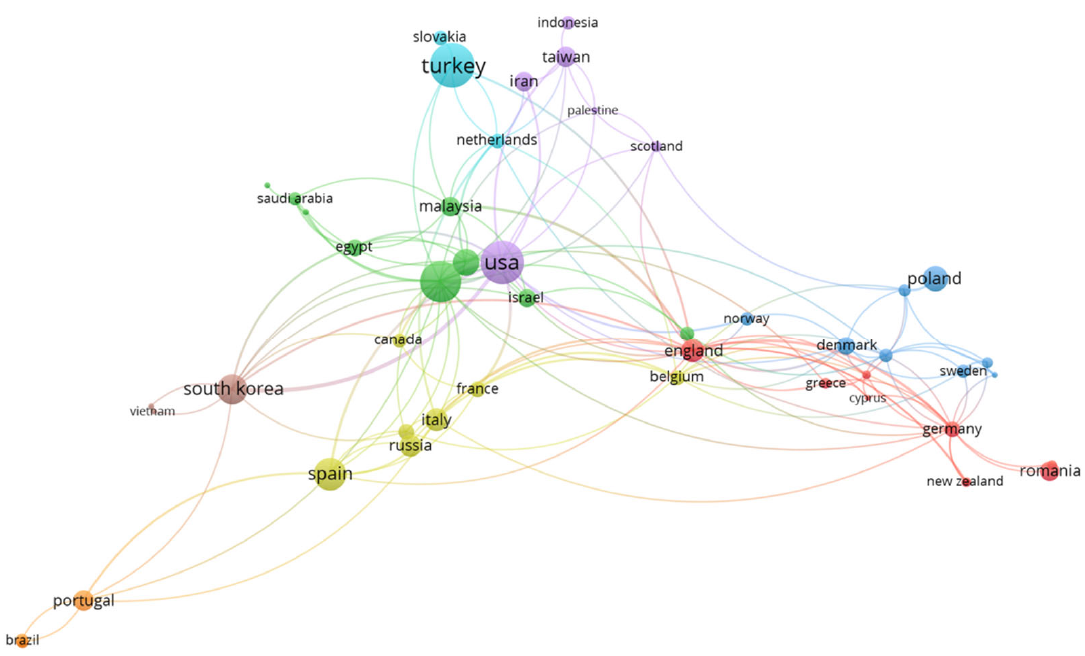
Figure 4. Co ‐ authorship network of countries.